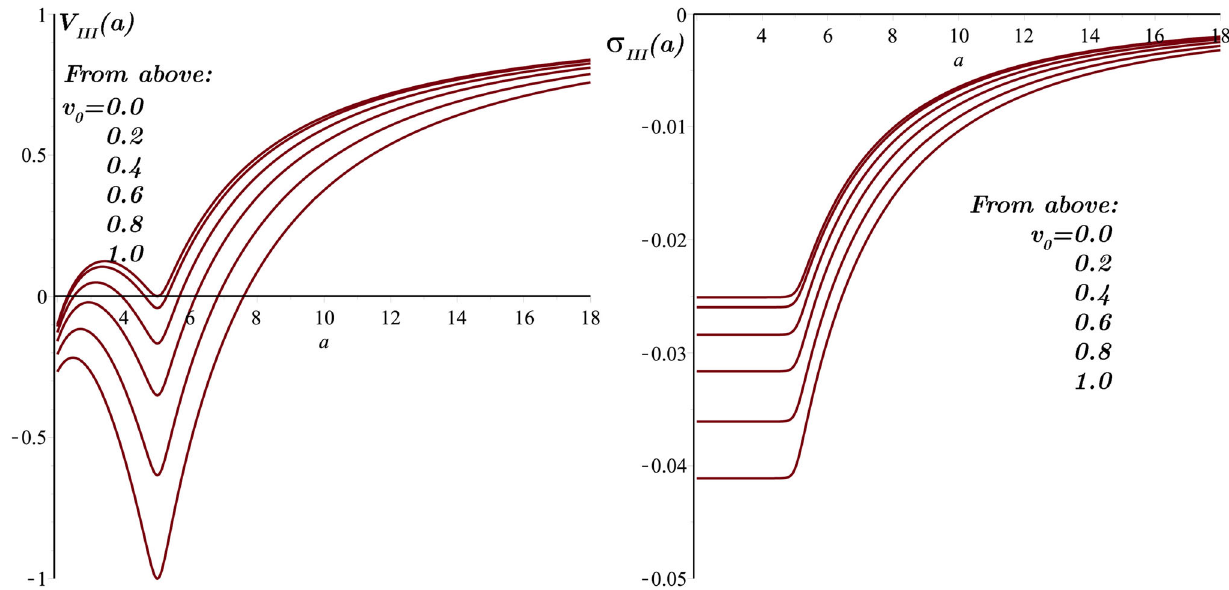
= − 16, M = 1 and from above v 0